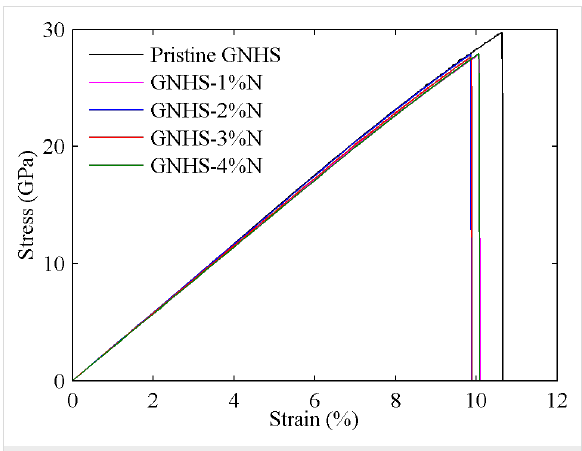
Figure 3: Stress–strain curves of GNHS with different percentage of N-dopants between 1% and